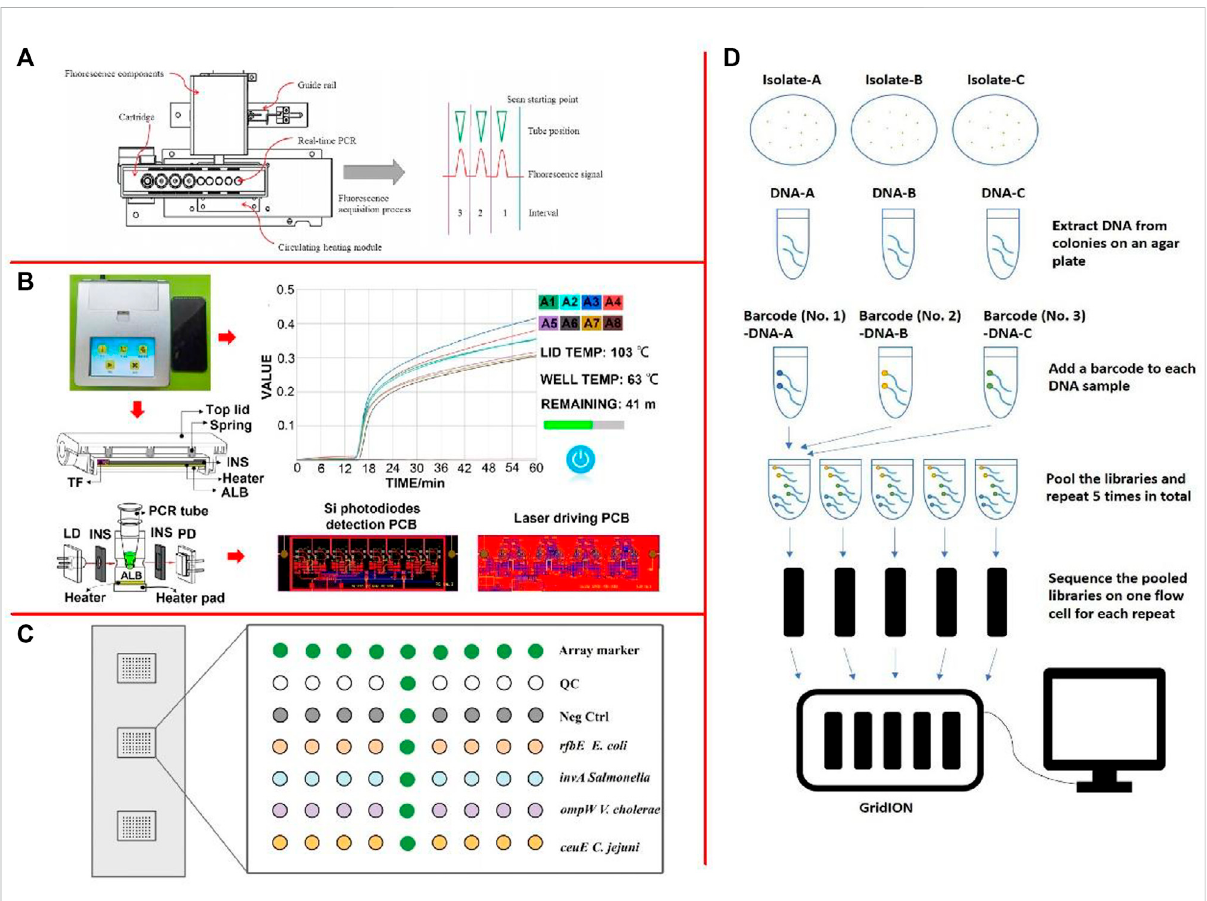
FIGURE 3 (A) Positions of the fl uorescence detection module and the Peltier device, and the principle of fl uorescence acquisition (Chen et al., 2017); (B) The design of the diagnostic device (Chen et al., 2022); (C) Layout of oligonucleotide probes on the detection microarray (Liu et al., 2017b); (D)